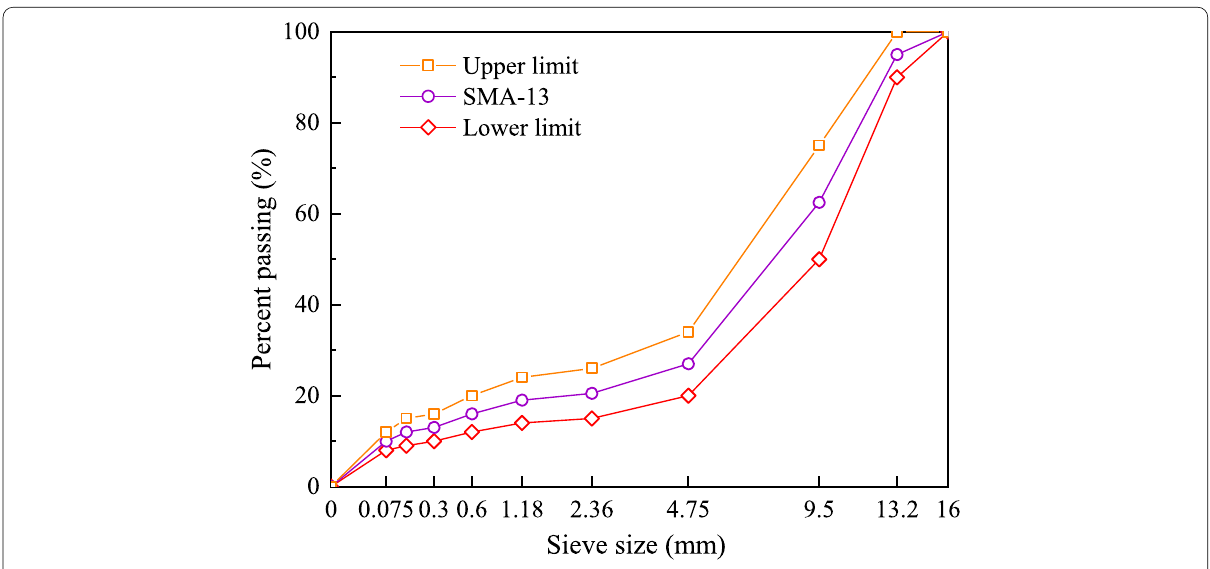
Fig. 1 Aggregate gradation curves for SMA-13